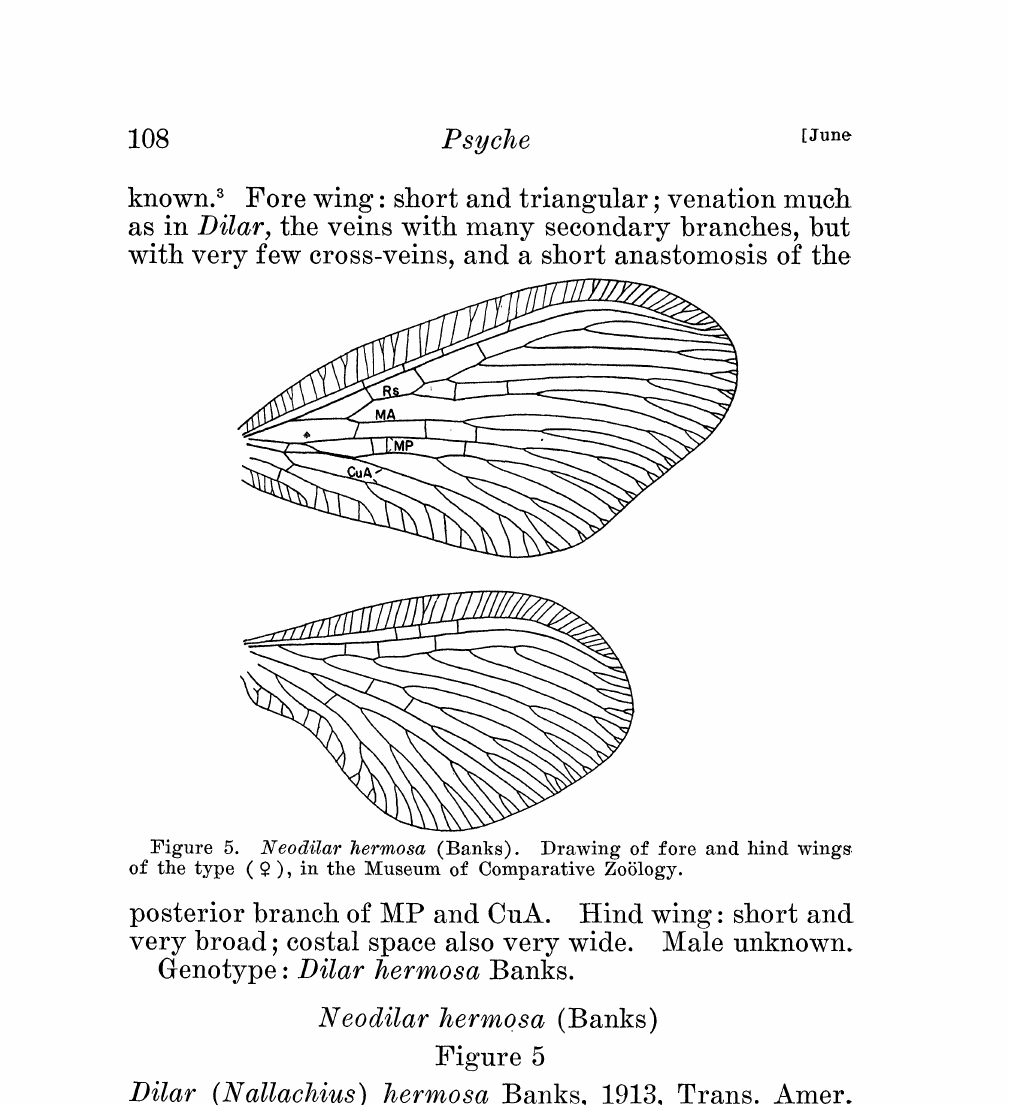
Figure 5. Neodilar hermosa (Banks). Drawing of fore and hind wings. of the type ), in the useum of Comparative